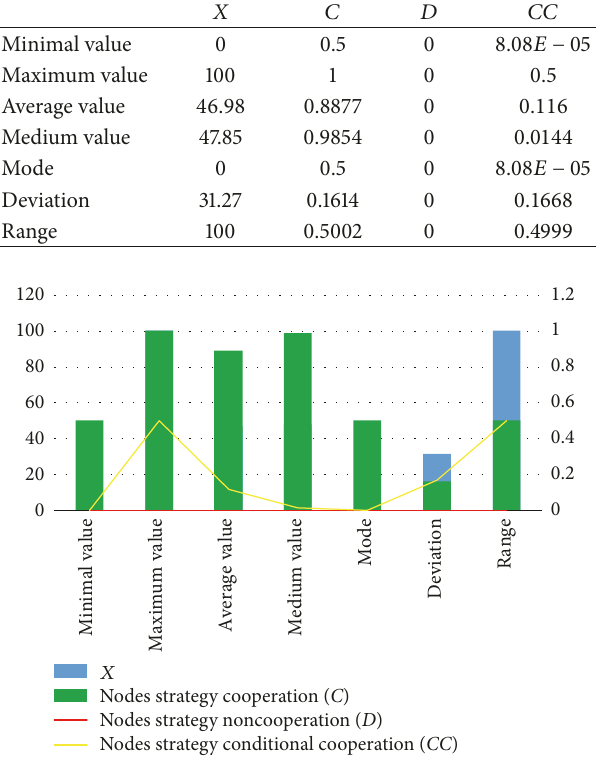
Figure 7: The state of population when 𝑋 = (0, 100, 46.98, 47.85, 0, 31.27, 100).